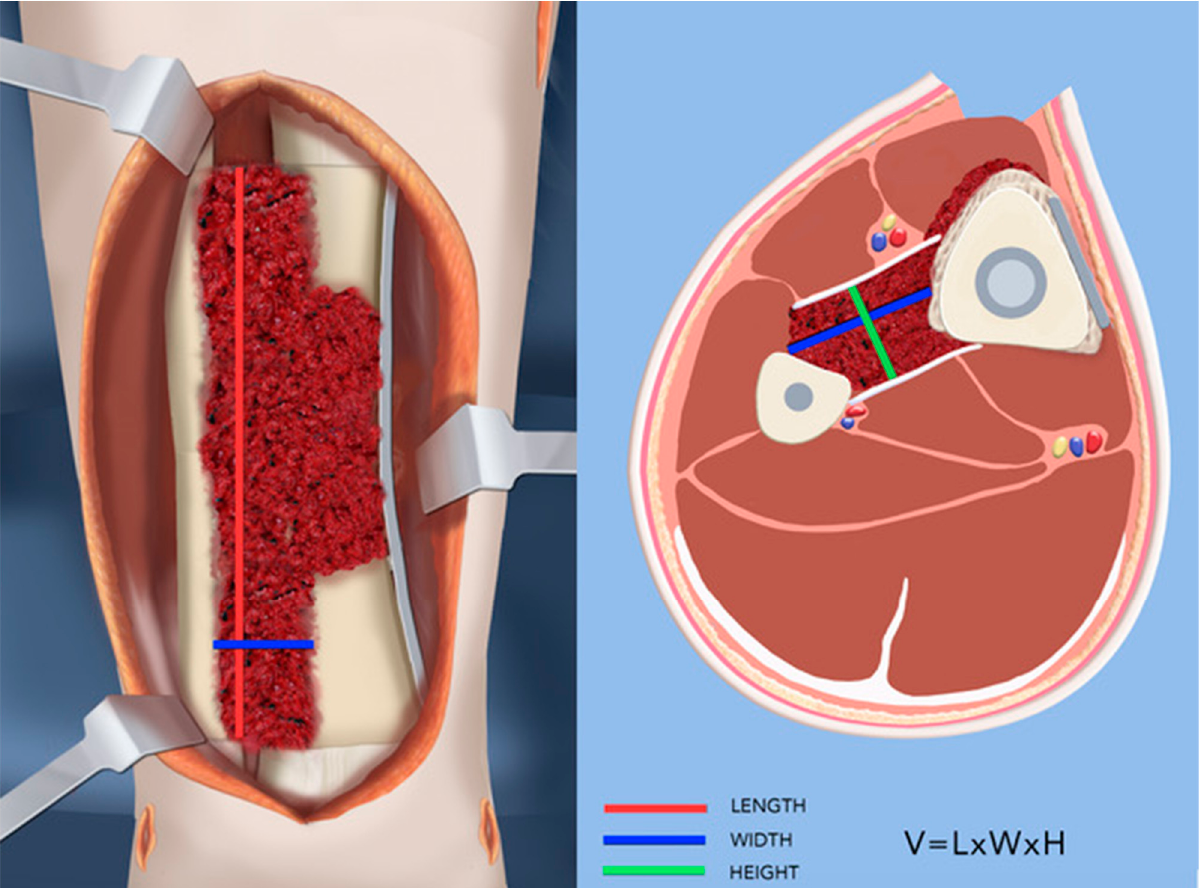
Figure 4. Illustration of the calculation of THE volume of bone graft needed: Volume (V) = the length of the planned cross-union (X) x the width between the two bones (Y) x the height of the space between the bones (Z). This is a large volume of autogenous cancellous bone to procure, especially in a very